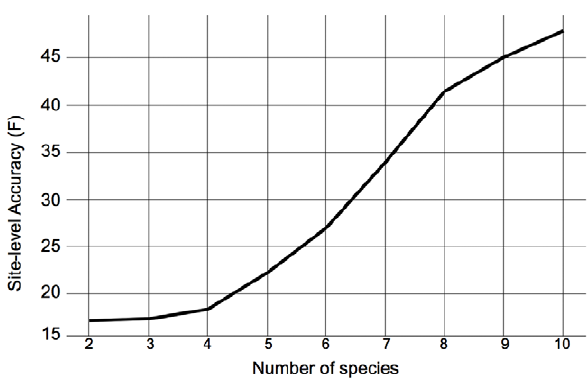
Figure 4. Site-level prediction accuracy as a function of number of species in EVOS simulation runs (the simulator and predictor modeled the same number of species).